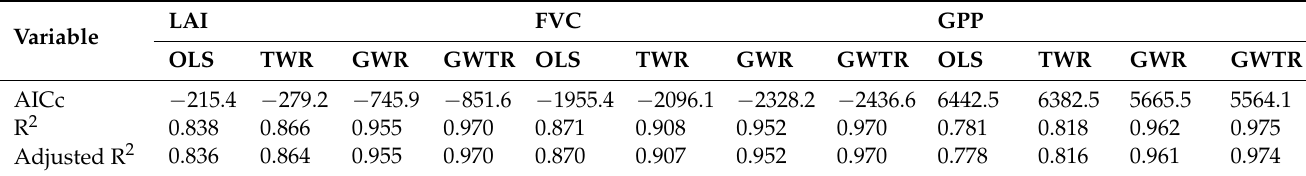
Table 6. The summarized results of the ordinary least squares regression (OLS) model, temporally weighted regression (TWR) model, and geographically weighted regression (GWR) model for